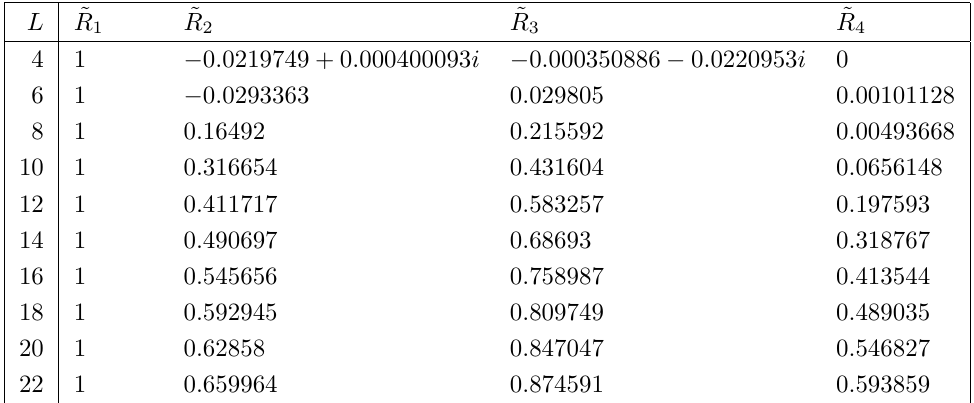
Table 7 . R m (A.3) of Φ G at the truncation level L for m = 1 , 2 , 3 , 4 . a = − 1 / 2